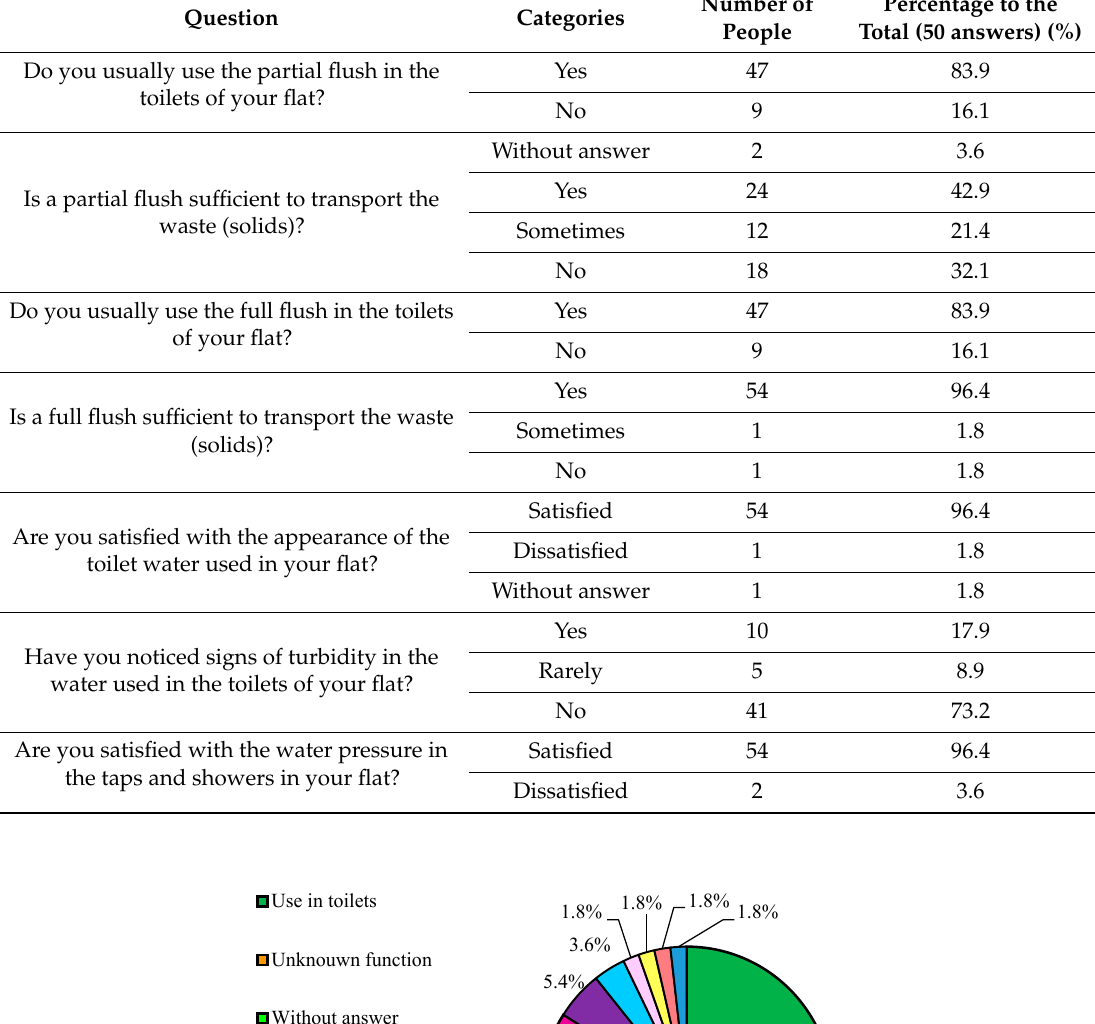
Table 9. Questions related to toilet usage habits, toilet flush performance, satisfaction with the appearance of water and the water pressure used in taps and showers.